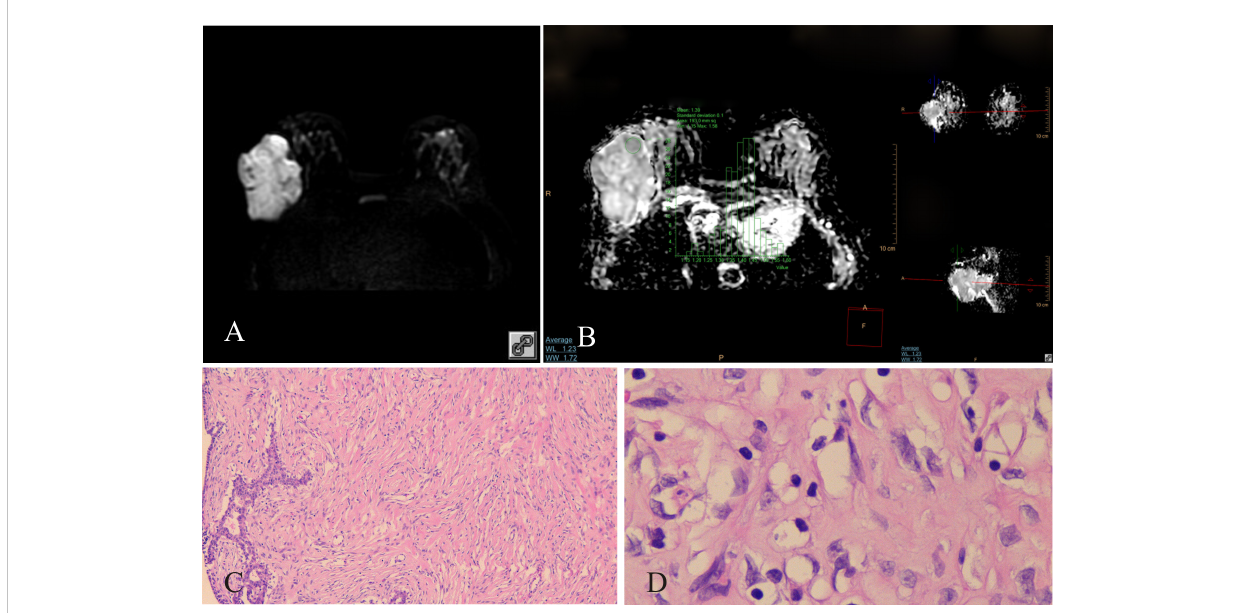
FIGURE 1 Benign PT of the right breast, female, age 46 years. (A) DWI (b800s/mm 2 ): mixed hyperintense signal; (B) ADC map: isointense – hyperintense mixed signal, ADCmean = 1.39 × 10 − 3 mm 2 /s; (C) HE ×100: tumor stromal cells were dispersed; (D) HE ×400: no nuclear division was observed, tumor cells were loosely